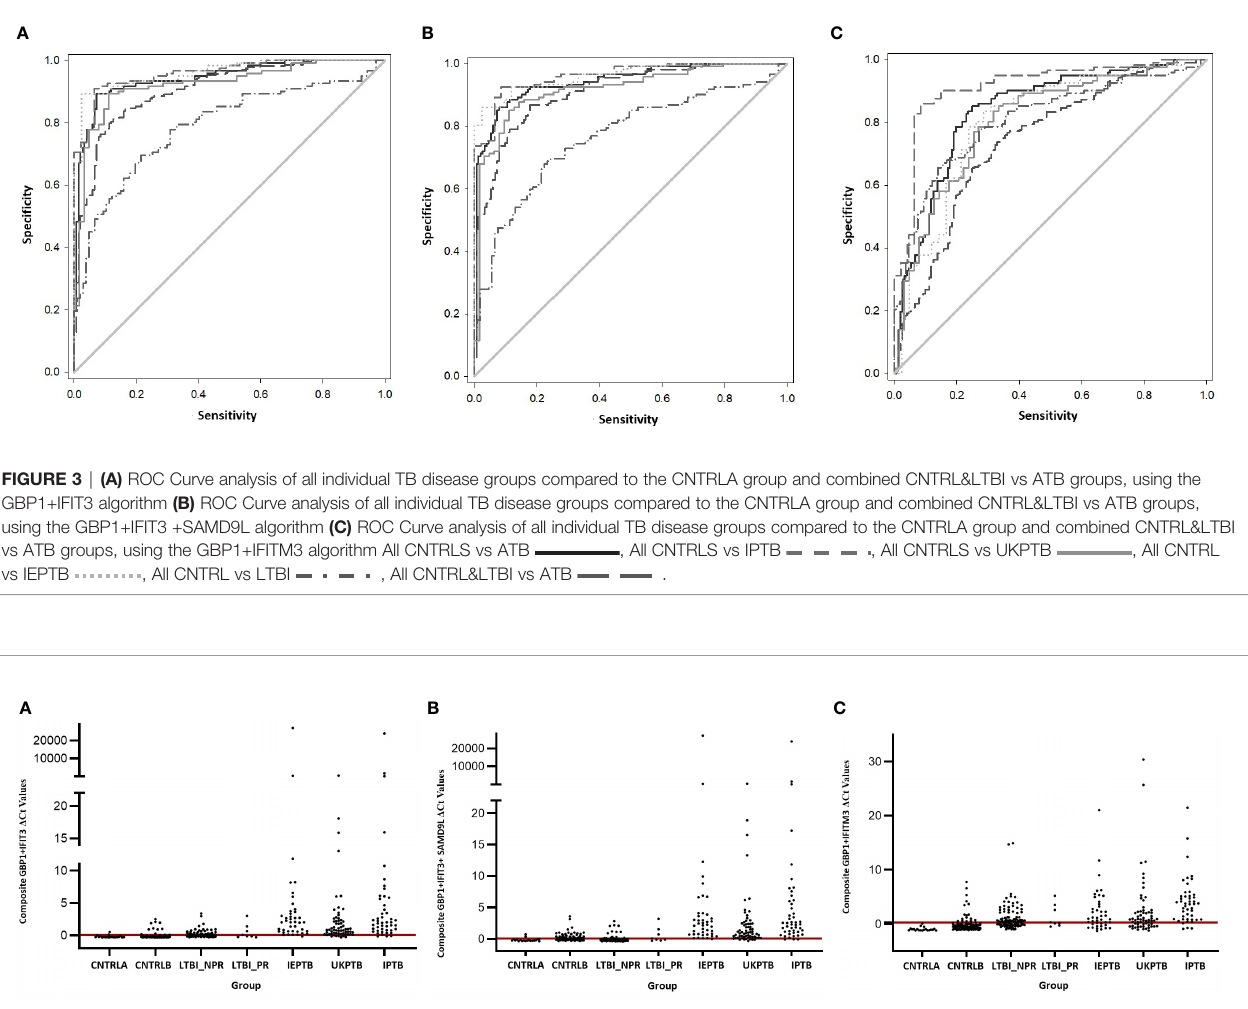
FIGURE 4 | Scatter plot representations of data from analyses using the GBP1+IFIT3, GBP1+IFIT3 +SAMD9L and GBP1+IFITM3 algorithms across all control and TB disease groups including the LTBI non-progressor and progressors (A) GBP1+IFIT3 algorithm using the calculated cut-off value which discriminates ATB from all combined control groups (-0.046). (B) GBP1+IFIT3 +SAMD9L algorithm using the calculated cut-off value which discriminates ATB from all combined control groups (-0.036) (C) GBP1+IFITM3 algorithm using the calculated cut-off value which discriminates the LTBI from all combined control groups